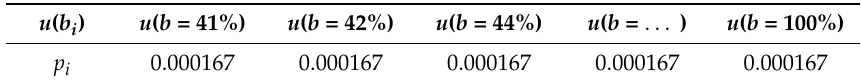
Table 8. The probability values of disruptions in the operation of the S 2 network corresponding to the b discount on the second